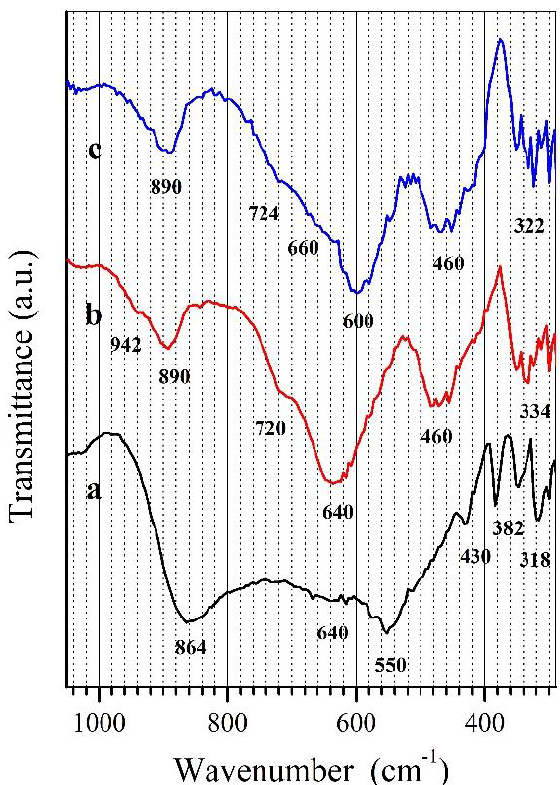
Figure 2. IR spectra of: ( a ) CuV 2 O 6 , ( b ) CuTa 1.70 V 0.30 O 6 (x = 0.30), ( c ) CuTa 2 O 6 . The IR spectrum of CuV 2 O 6 comprised two broad absorption bands with maxima at 864 and 550 cm − 1 (Figure 2, curve a). The absorption band with a maximum at 864 cm − 1 can be ascribed to stretching vibrations of V-O bonds in distorted VO 6 octahedra (characteristic for CuV 2 O 6 structure) [48,50]. IR spectra of solid solution CuTa 1.70 V 0.30 O 6 (x = 0.30), (Figure 2, curve b), and its matrix CuTa 2 O 6 (Figure 2, curve c) contains four bands in the boundaries of 950–850 cm − 1 , 750–550 cm − 1 , 520–430 cm − 1 and 380–300 cm − 1 with maxima at about 890, 640, 460 and 330 cm − 1 . It follows from the literature survey that these bands are characteristic of solid tantalates (V) and vanadates (V) [48,50–53]. The similarity of these IR spectra corroborates that the solid solution adopts the CuTa 2 O 6 structure. An intensive band with an absorption maximum registered in the region 950–850 cm − 1 at ~870 cm − 1 can be attributed to the stretching vibrations of Ta-O and V-O bonds in distorted TaO 6 and TaO 7 as well as VO 4 and VO 6 polyhedra [48,49,51,52,54]. Bands in the range of 750 to 550 cm − 1 and 520–430 cm − 1 can be attributed to the stretching vibrations of the Cu-O bonds in the distorted CuO x polyhedra [45,46] and the stretching vibrations of M-O (M = Ta, V) bonds in the moderately distorted MO 7 , MO 6 and VO 4 polyhedra [48–54]. The bands registered in the range of 350 to 330 cm − 1 can be attributed to bending vibrations of the O-M-O bridges (M = Cu, Ta, V), or they are of mixed character [48–50,53]. The comparative analysis of positions and intensities of absorption bands in IR spectra of CuTa 2 O 6 and CuTa 2 − x V x O 6 solid solution samples has revealed that incorporation